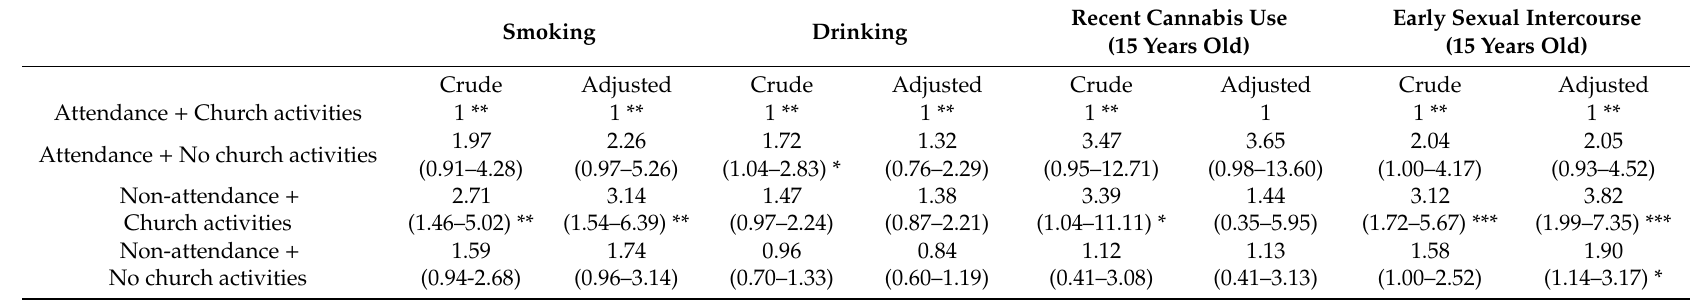
Table 3. Associations of adolescent smoking, drinking, recent cannabis use, and early sexual intercourse with di ff erent combinations of religious attendance with church activities, crude and, adjusted for age, gender, socioeconomic status (FAS), and social media use (odds ratios and 95% confidence